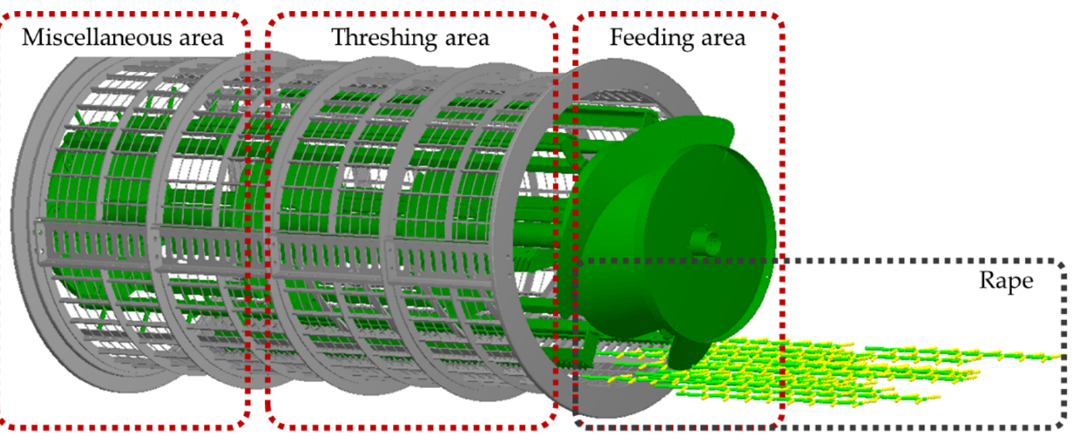
Table 4. Simulation environment.